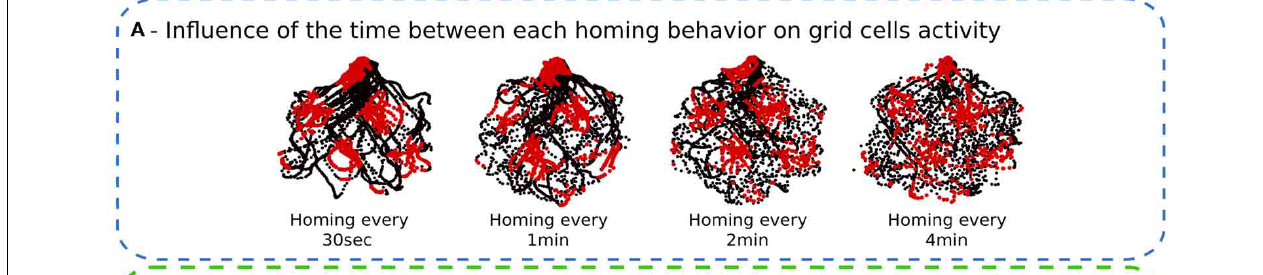
30 min), and the activity of a grid cell every 3 min after inhibiting calibration. Blurring activity appears as a gaussian noise with time. (C) Influence of the PI shift on the grid-like pattern without vision (Experiment 5). After 30 min of random navigation with a calibration every minute, the robot is blindfolded. It keeps moving for another 30 min without vision. It keeps trying to go back home every minute but only with PI and ultrasound sensors profile. A calibration of PI occurs only when the right place cell, computed from grid cells, is winning and when head-on proximity sensors (US) rise a high-level threshold. Left, resetting area for the entire experiment duration. Reset activity appears distributed in space on the border of the environment. Right, activity of a grid cell every 3 min after blindfolding. Spreading activity appears to be the result of a rotation of the initial grid pattern. Because of inaccurate border calibrations, grid cell activity shifts in orientation but keeps its original spatial